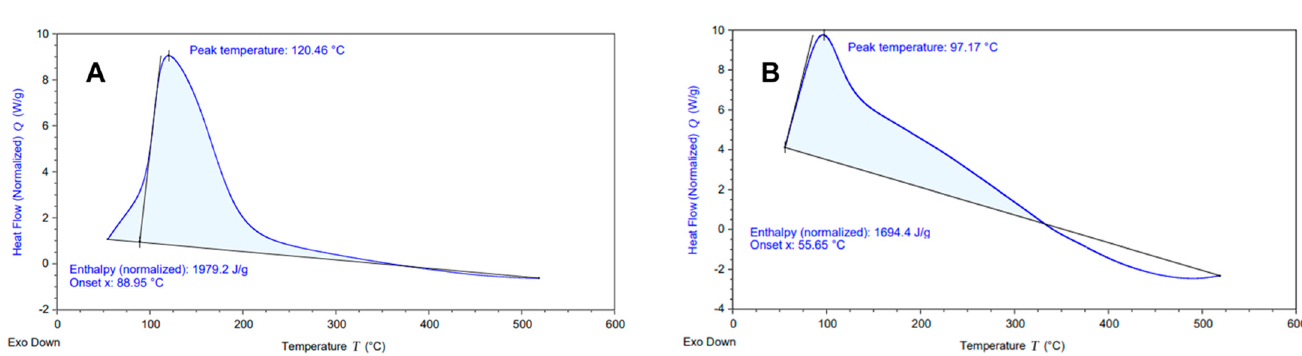
Figure 3. DSC thermograms of the root ( A ) and aerial ( B ) tissue of the D. antarctica